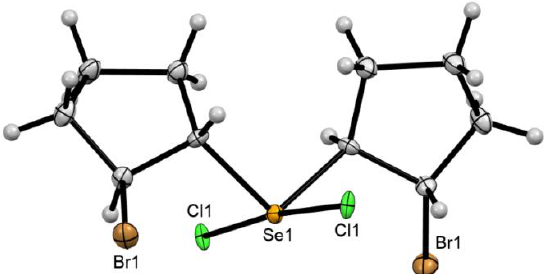
Figure 1. ORTEP molecular structure of trans,trans -dichloro[bis(2-bromocyclopentyl)]-λ 4 -selane ( 2 ) at 50% thermal ellipsoid probability.